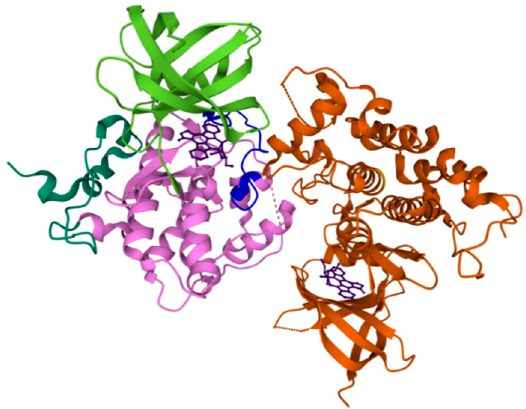
Figure 2. Stereo pair secondary structure cartoon of human GSK-3 β in complex with staurosporine ( 3 ) (purple) PDB ID: 1Q3D [31]. The β -strand domain at the N -terminal end is depicted in light green, the α -helical domain at the C -terminal end is depicted in pink, and the activation loop is depicted in blue.